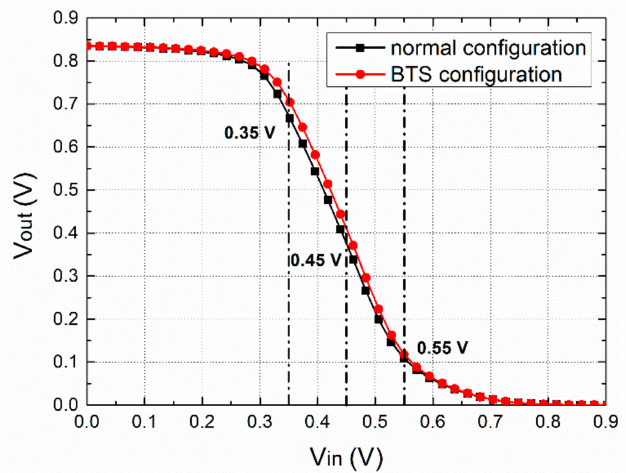
Figure 2. Input and output characteristics of the CS